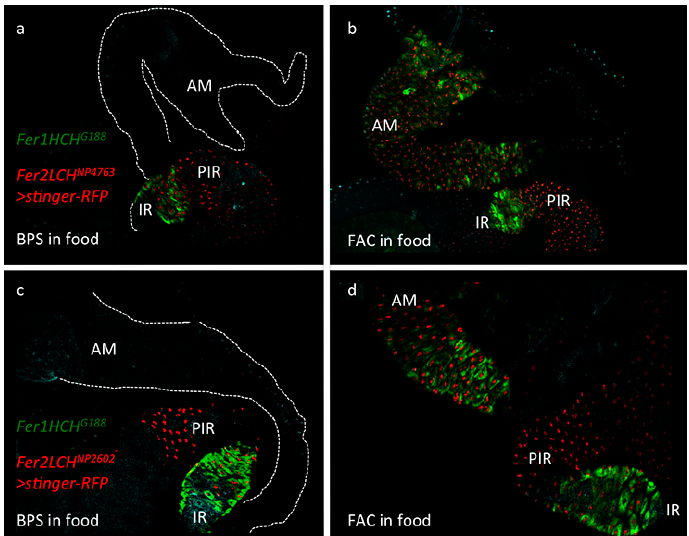
Figure 1. ( a ) Expression pattern of the Fer2LCH NP 4763 -Gal4 driver line in the larval intestine as revealed by the nuclear stinger red fluorescent protein originating from UAS-stinger-RFP . Larvae were raised on a diet containing 200 µM of the iron chelator Bathophenanthroline Sulfate (BPS). Note that all cells of the iron region (IR), marked by Green Fluorescent Protein tagged Ferritin 1 Heavy Chain Homolog (GFP-Fer1HCH) from the Fer1HCH G 188 allele, also express stinger-RFP, but the Gal4 driver expresses in cells posterior to the iron region (PIR) as well. The anterior midgut (AM) is marked with a dotted line in the top part of the panel; ( b ) The same genotype Fer1HCH G188 / Fer2LCH NP4763 , UAS-stinger-RFP raised on a diet supplemented with 1 mM Ferric Ammonium Citrate (FAC). Note the clear coincidence in anterior midgut cells of red fluorescence in the nuclei and green fluorescence in the cytoplasm. This region specifically responds to iron by expressing ferritin and the Fer2LCH NP4763 -Gal4 driver faithfully recapitulates the endogenous enhancer in this region of the intestine; ( c ) An identical pattern of expression for ferritin could be seen with the independent Fer2LCH NP2602 -Gal4 driver line in BPS treated larvae ( d ) and in the FAC treatment.